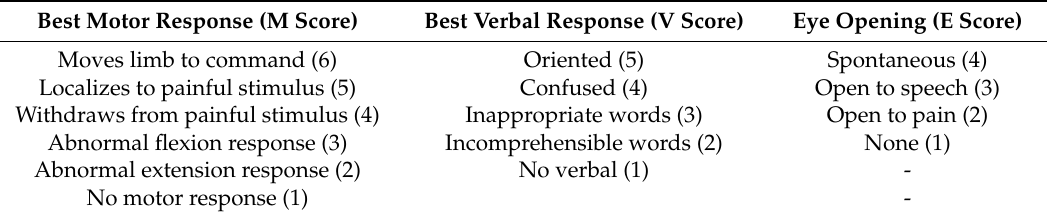
Table 1. Glasgow Coma Scale (GCS) components.